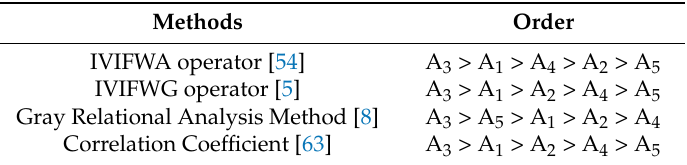
Table 7. The order of the tourism scenic